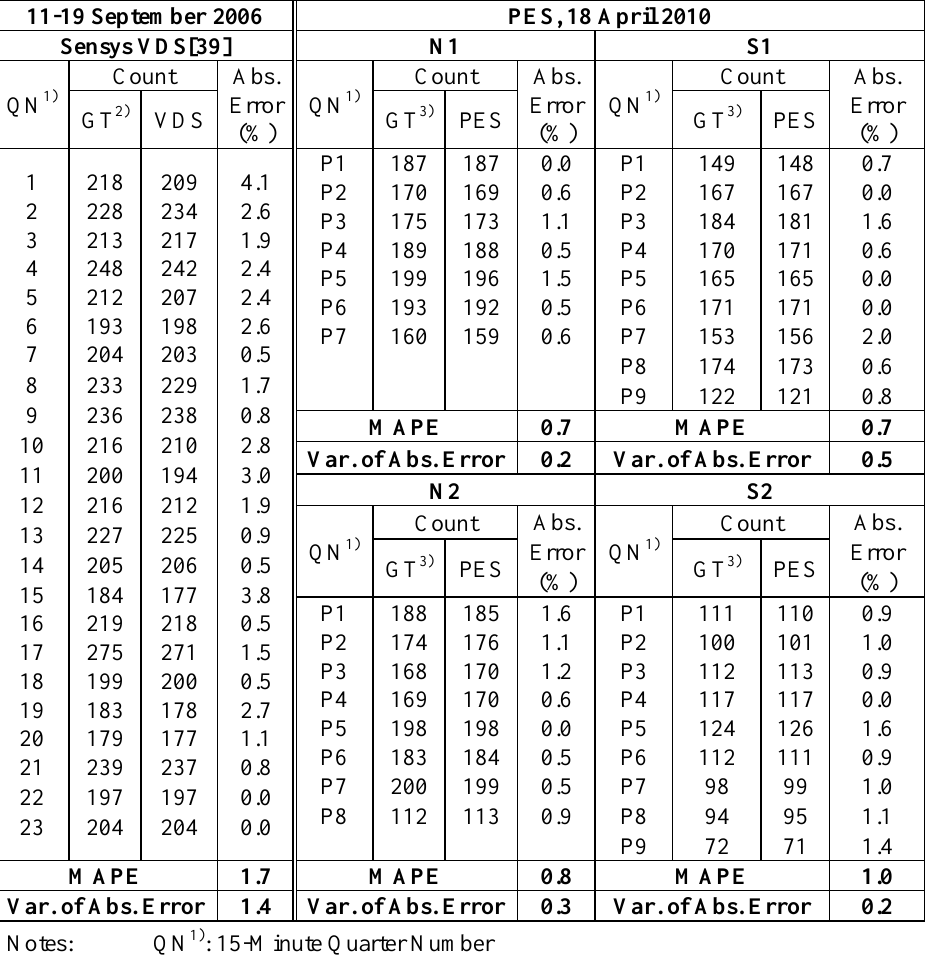
Table 7. Volume count accuracy comparison between PES and Sensys VDS